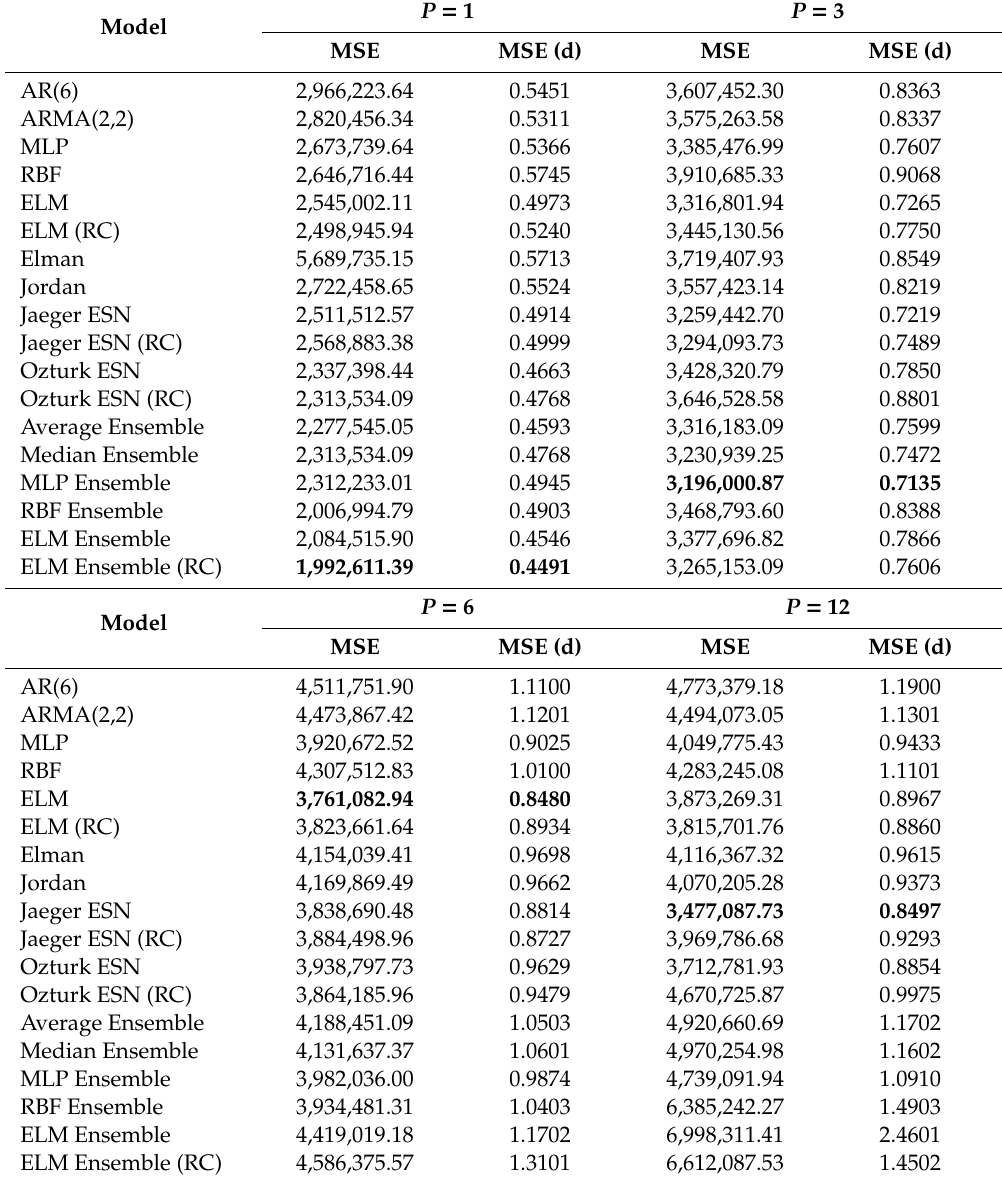
Table 4. Computational results for Ilha